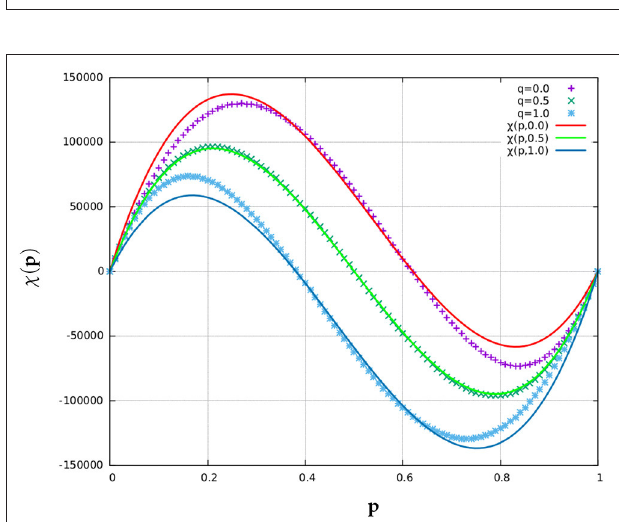
FIGURE 11 | This plot shows how the number of clusters of two specific sizes 1 and 10 vary with p .